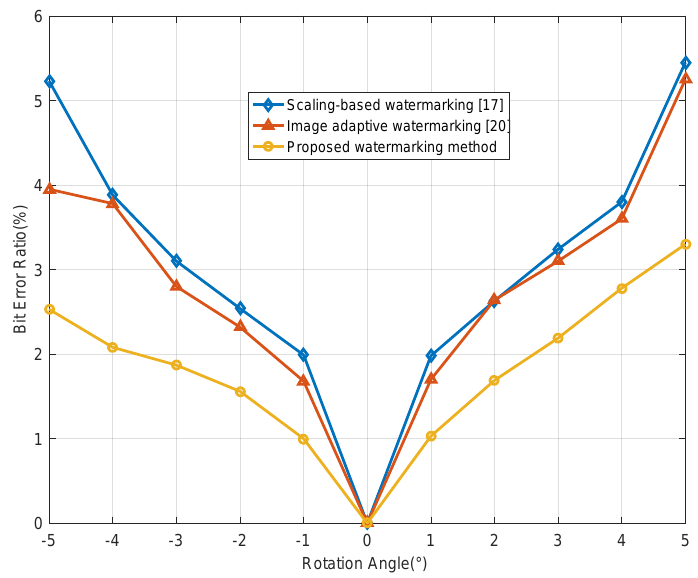
Figure 7. Performance comparison of various algorithms under rotation